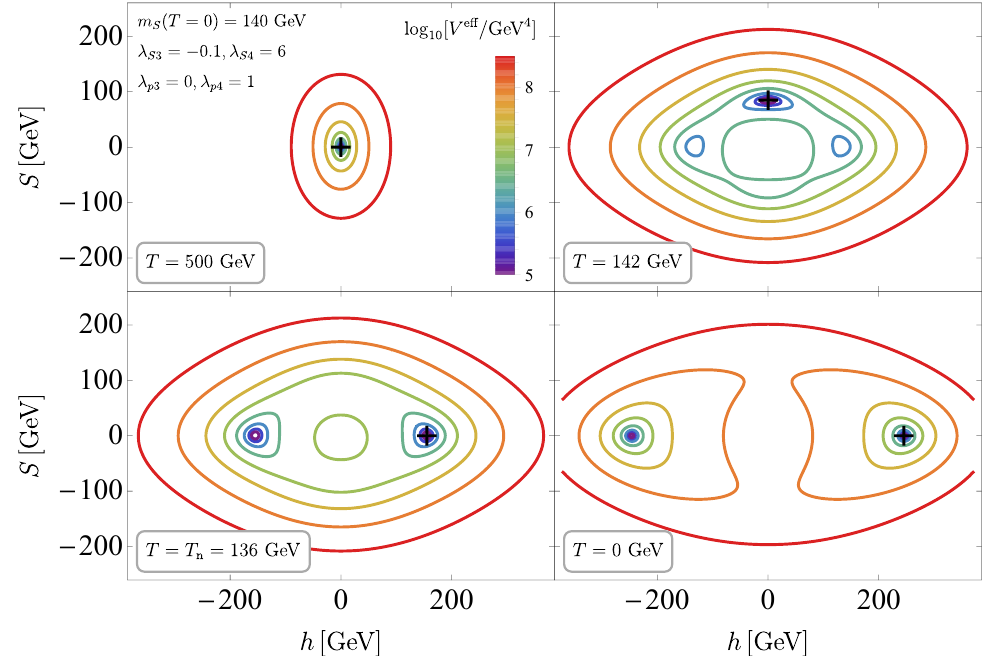
Figure 4 . The e(cid:11)ective potential V e(cid:11) for a particular parameter point in the vev-induced DM production scenario de(cid:12)ned in eq. (3.1). The black cross indicates the phase the Universe is in at the given temperatures. The two-step phase transition (\vev (cid:13)ip-(cid:13)op") is clearly visible: at T = 500 GeV (top left), both h S i and h h i vanish, as V e(cid:11) is dominated by thermal corrections. At a lower temperature, the Universe transitions to the h S i 6 = 0, h h i = 0 phase (top right), but eventually the minimum with h S i = 0, h h i 6 = 0 becomes the global one, so the Universe transitions into it and remains there (bottom left and bottom